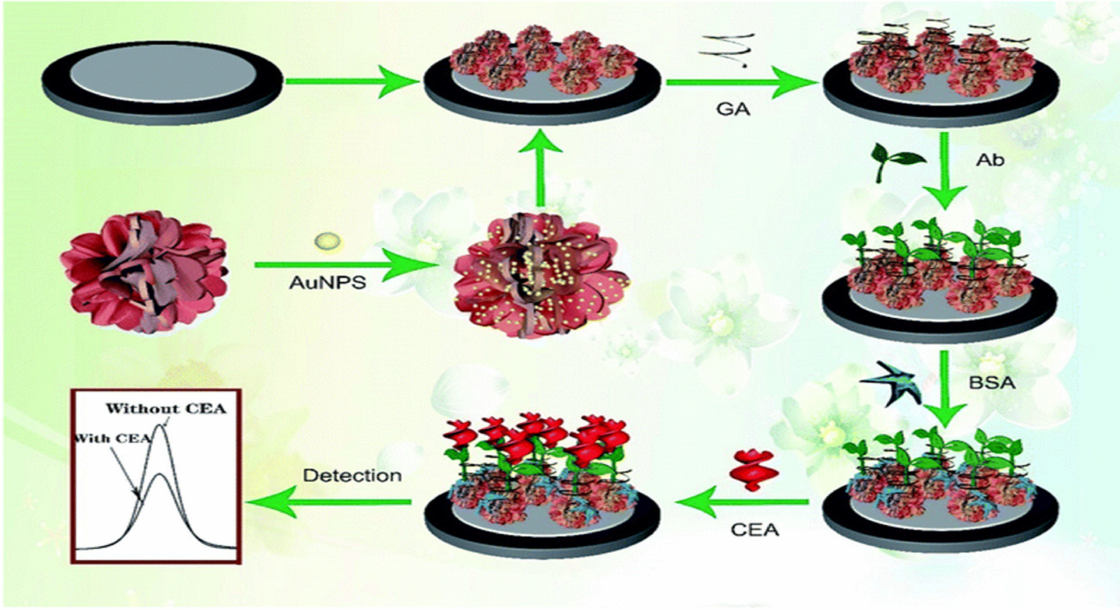
Figure 3. Schematic illustration of the fabrication procedure for CEA immunosensor. GA: glutaralde- hyde; Ab: antibody; BSA: bovine serum albumin. Reprinted with permission from [43], published by The Royal Society of Chemistry,